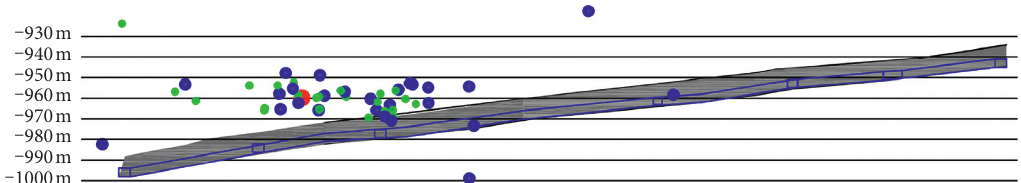
Figure 5: Vertical distribution of microseismic events during the rock burst